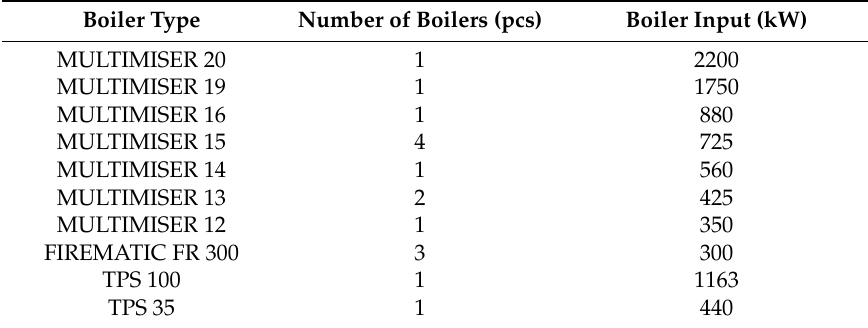
Table 1. Types of boilers and their boiler